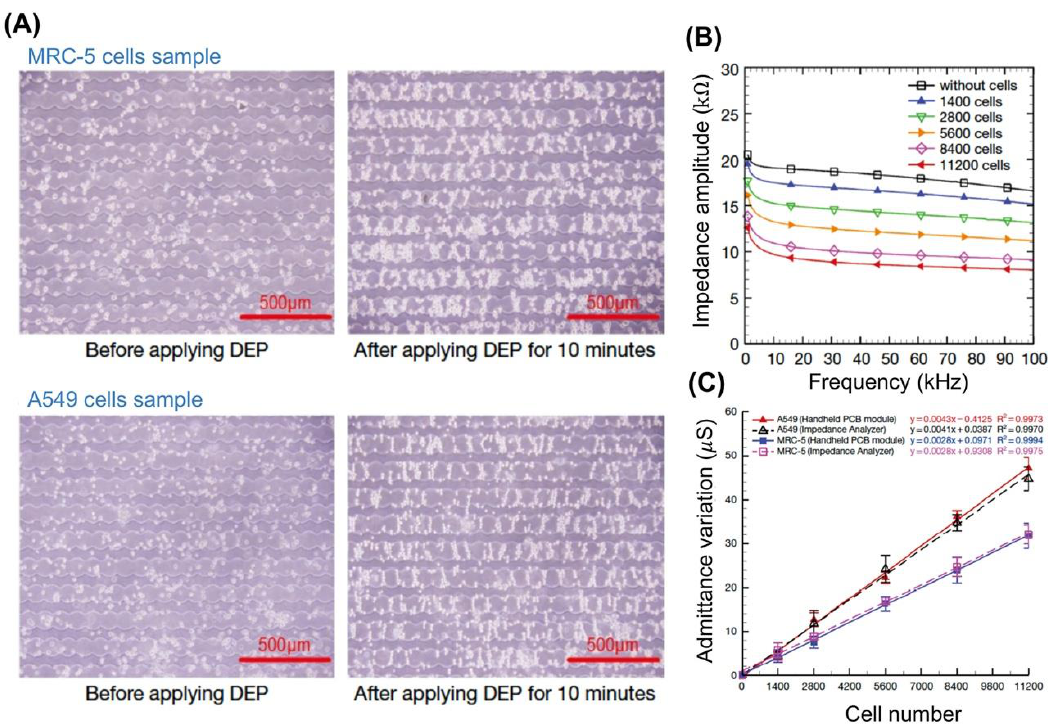
Figure 6. ( A ) DEP patterning of human lung carcinoma (A549) and lung epithelial cells (MCR-5). ( B ) Impedance spectrums for A549 cells at various cell concentrations. ( C ) Experimental data with trendlines for admittance measurements for A549 and MCR-5 cells. Reprinted with permission from [82].